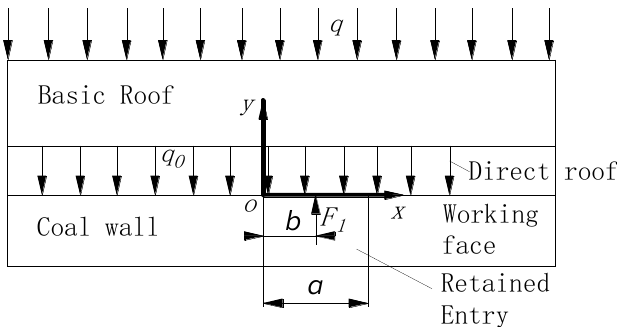
Figure 17. Simplified mechanical model of the coal support Figure 17 . Simplified mechanical model of the coal support area .